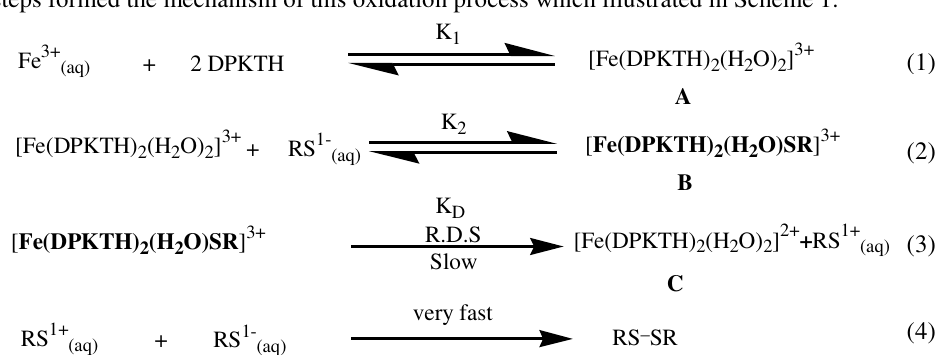
Table 2. Activation parameters of the rate-determining step calculated from Arrhenius equation by plotting ln initial rate vs. 1/ T K -1 , at λ